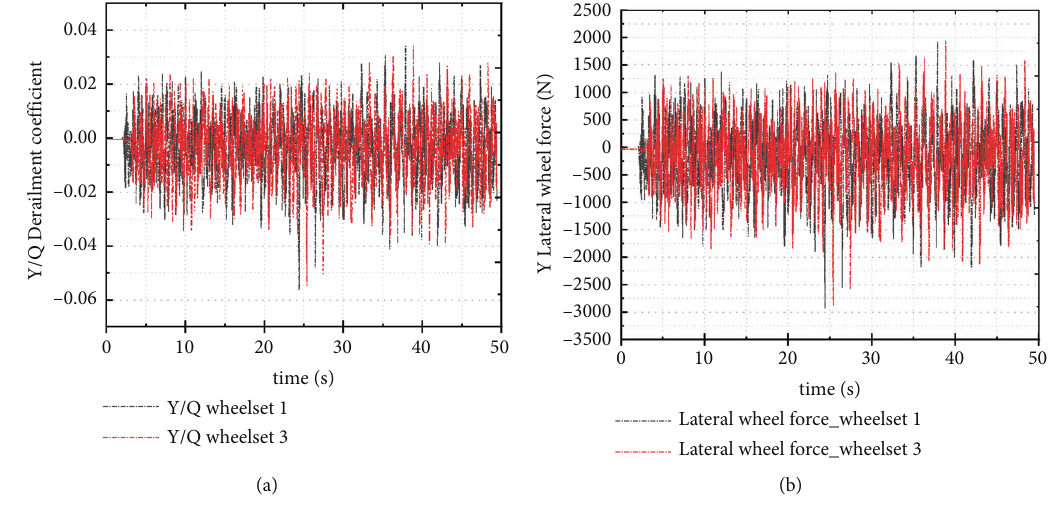
Figure 6: (a) Derailment coe ffi cient of wheelset 1 and 3 and (b) lateral force of wheelset 1and 3.